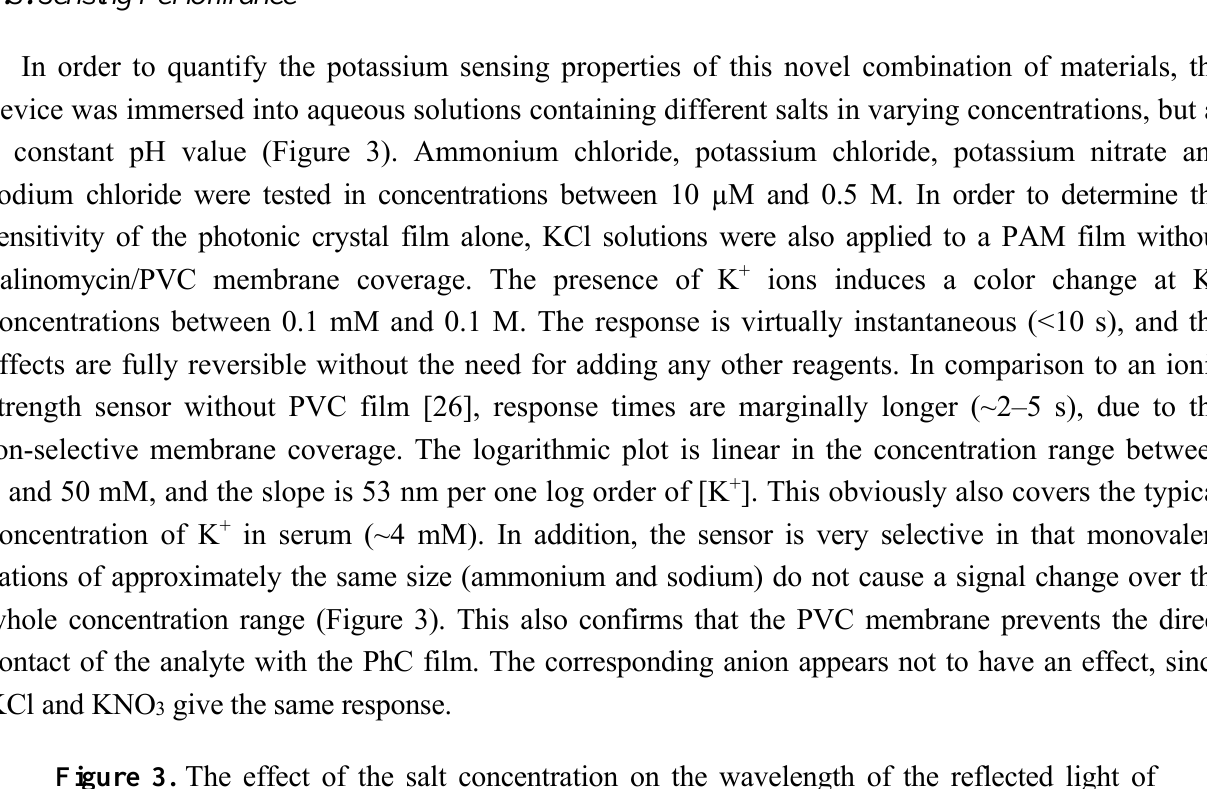
Figure 3. The effect of the salt concentration on the wavelength of the reflected light of colloidal PhCs in a hydrolyzed PAM hydrogel covered with a K + -selective membrane. The film was immersed into solutions of KCl, KNO 3 , NaCl and NH 4 Cl of varying concentrations. Each data point represents the average of five measurements; the error bars display the respective standard